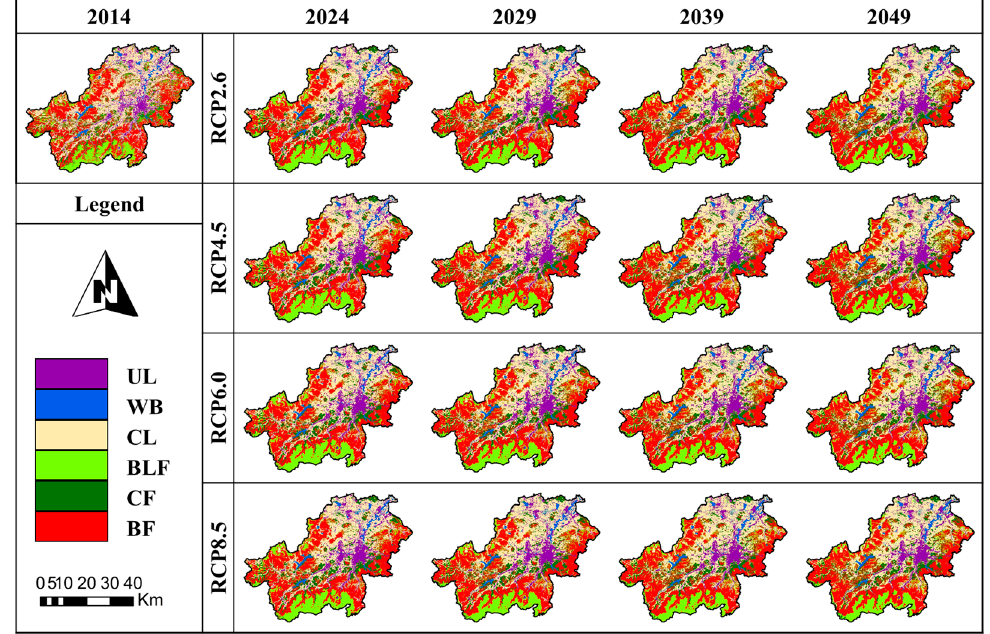
Figure 12. Simulated result of Anji County in 2014 and different simulated results of Anji County in four scenarios from 2024–2049.